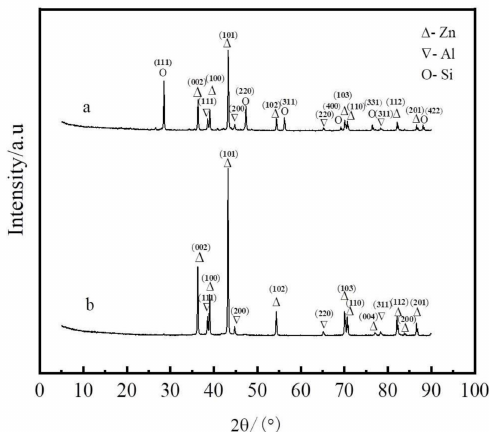
Figure 8. XRD patterns of the Zn–Al alloy and slag. ( a ) Slag; ( b ) Zn–Al alloy.